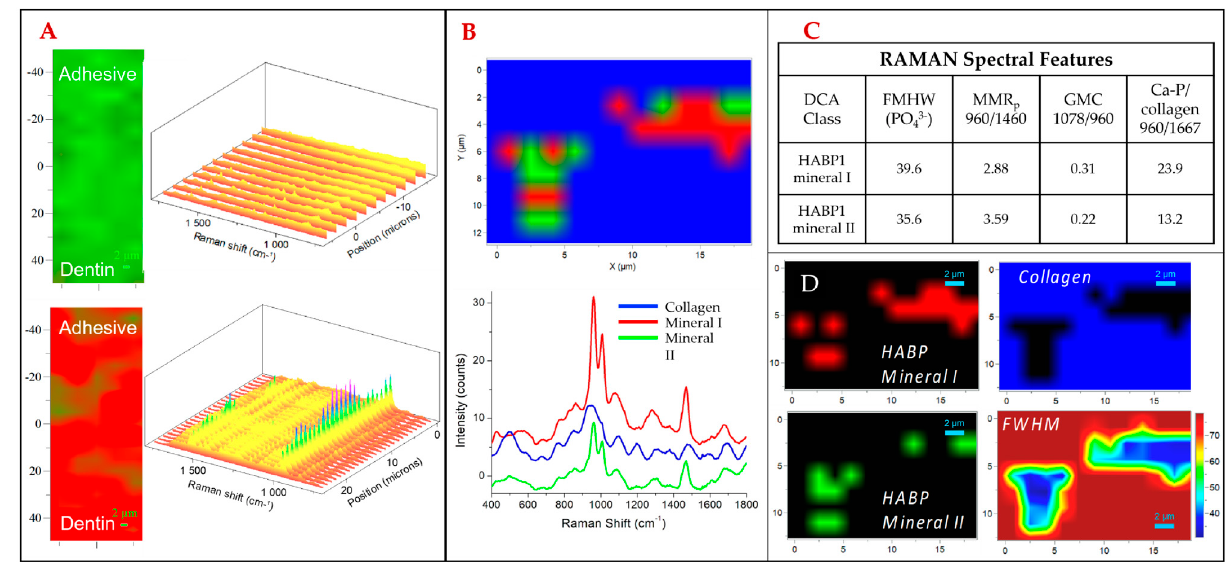
Figure 2. ( A ) RAMAN imaging with spectral analysis adjacent of A/D interface pre/post ALP − driven mineralization with HABP1 present. ( B ) RAMAN DCA of HABP1 mineralized surface on mineral types present and corresponding spectral analysis. ( C ) RAMAN spectral features evalu- ated over HABP1 mineral types observed. ( D ) Isolated DCA mapping of collagen, HABP1 mineral group I, HABP1 mineral group II, and full width at half maximum (FWHM) spatial mapping.